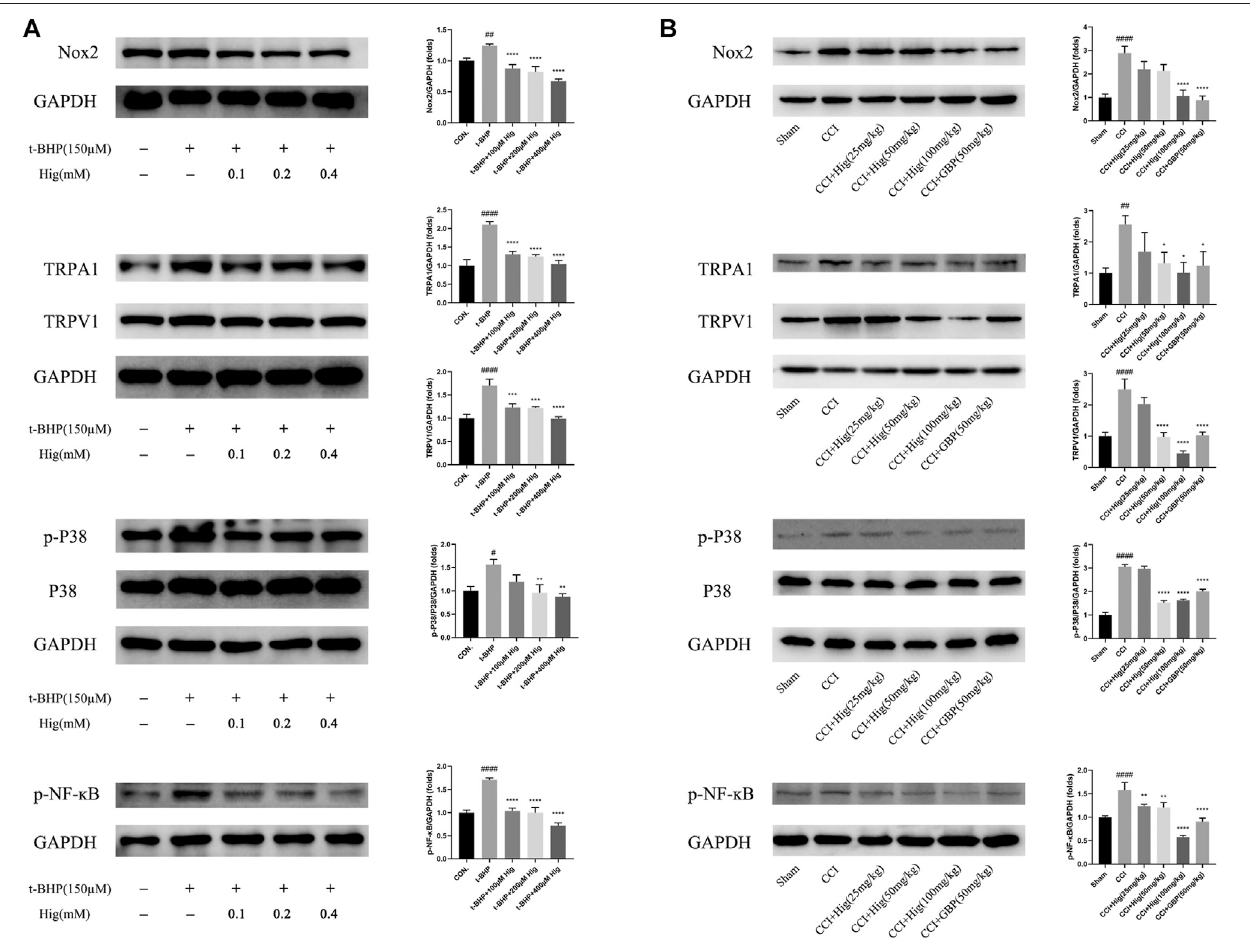
FIGURE 9 | Hig regulated the proteins expressed in Nox2/ROS/TRP/P38 MAPK/NF- ĸ B signaling pathway. (A) The control and t-BHP-exposed RSC96 were collectedandanalyzedbyWBforexpressionlevelofNox2,TRPA1,TRPV1,p38MAPK,p-p38MAPK,andp-NF- ĸ B. (B) TheDRGtissuesfromsham-operatedandCCI surgery were collected and analyzed by WB for expression level of Nox2, TRPA1, TRPV1, p38 MAPK, p-p38 MAPK, and p-NF- ĸ B. GAPGH served as internal control. The results are presented asmean ± SEM, n (cid:2) 3. # p < 0.05, ## p < 0.01, and #### p < 0.0001vs. thecontrol group. * p < 0.05, ** p < 0.01, *** p < 0.001, and **** p < 0.0001 vs. the model